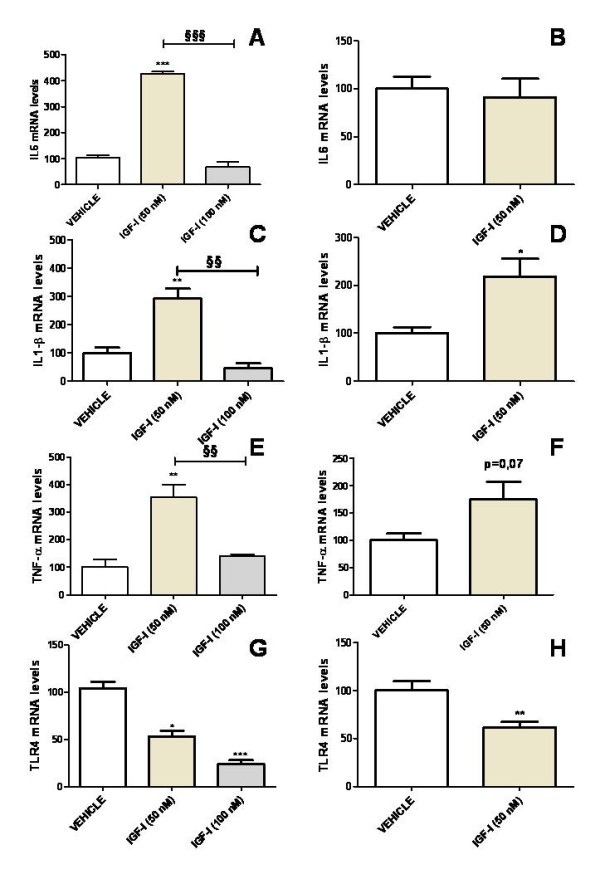
IGF-I increases the expression of IL6, IL-1β and TNF-α and decreases the expression of TLR4 in astrocytes under basal conditions. mRNA levels of IL6 (A,B), IL-1β (C,D), TNF-α (E,F) and TLR4 (G,H) in astrocytes 24 h (A,C,E,G) or 72 h (B,D,F,H) after the addition of IGF-I (50 or 100 nM) or vehicle to the cultures. Data are presented as mean ± SEM and are expressed as percentage of control (vehicle) values. *,**,***, Significant differences (* P < 0.05; **P < 0.01; ***P < 0.001) in comparison to the values of cultures treated with vehicle only. §§, §§§, Significant differences (§§P < 0.01; §§§P < 0.001) between 50 nM and 100 nM IGF-I.